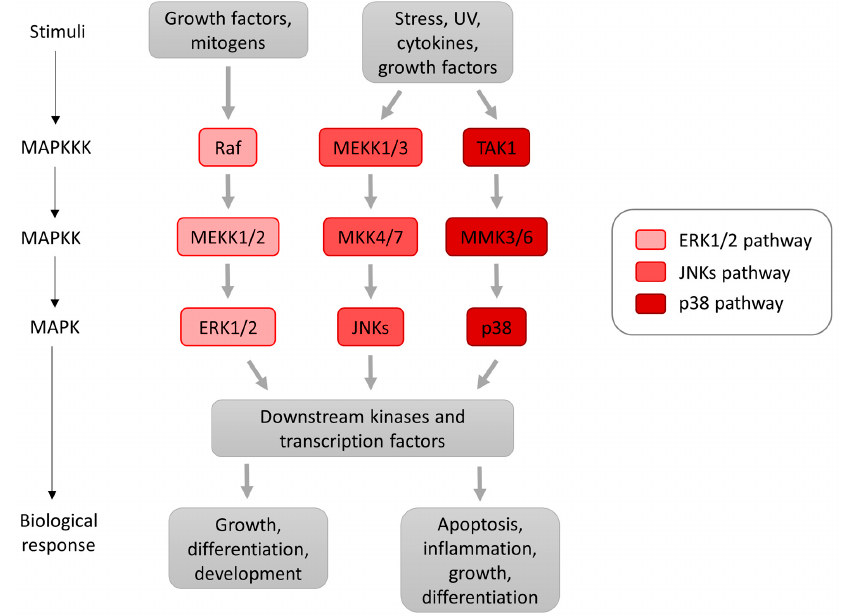
Figure 2. Schematic diagram of main mammalian mitogen-activated protein (MAP) kinase signalling pathways. Extracellular stimuli activate the MAP kinase pathways through mechanisms mediated by GTPases. Once MAP kinase kinase kinases (MAPKKKs), such as RAF proto-oncogene serine/threonine-protein kinase ( Raf) , mitogen-activated protein kinase kinase kinase 1 (MEKK1/3) and TAK (transforming growth factor β (TGF β )-activated kinase) are activated, they phosphorylate MAP kinase kinases (MAPKKs) which then phosphorylate and activate the extracellular signal-regulated kinases 1 and 2 (ERK1/2), c-JUN N-terminal kinases (JNKs) and p38 kinases. Activated MAP kinases can translocate to the nucleus to phosphorylate a number of transcription factors. The ERK1/2 pathway is predominantly activated by growth factors, whereas stress and inflammatory cytokines preferentially activate the JNKs and p38 pathways. Arrows indicate direct stimulatory modification. UV: ultraviolet.